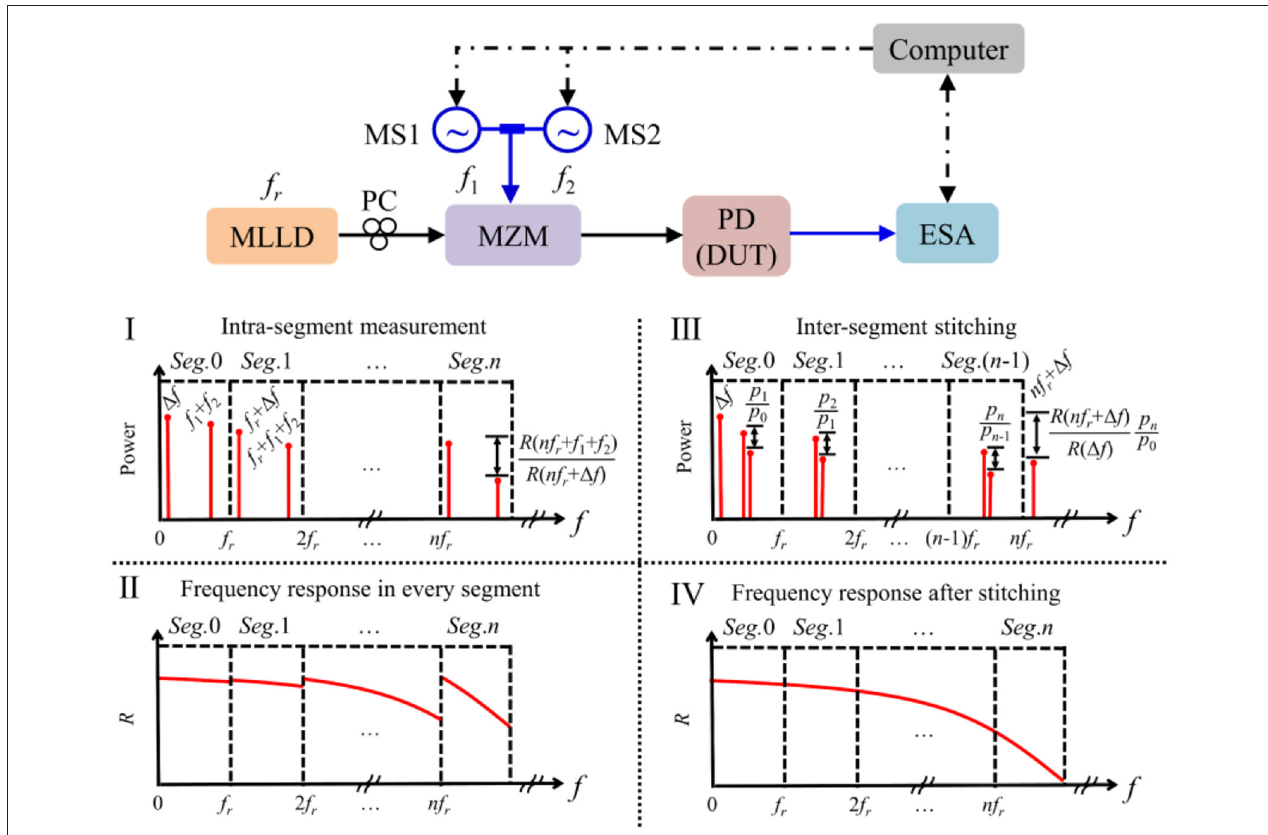
FIGURE 1 | Schematic diagram of the proposed two-tone photonic sampling method, MLLD, mode-locked laser diode; PC, polarization controller; MZM, mach-zehnder modulator; MS, microwave source; PD, photodetector; DUT, device under test; ESA, electrical spectrum analyzer.